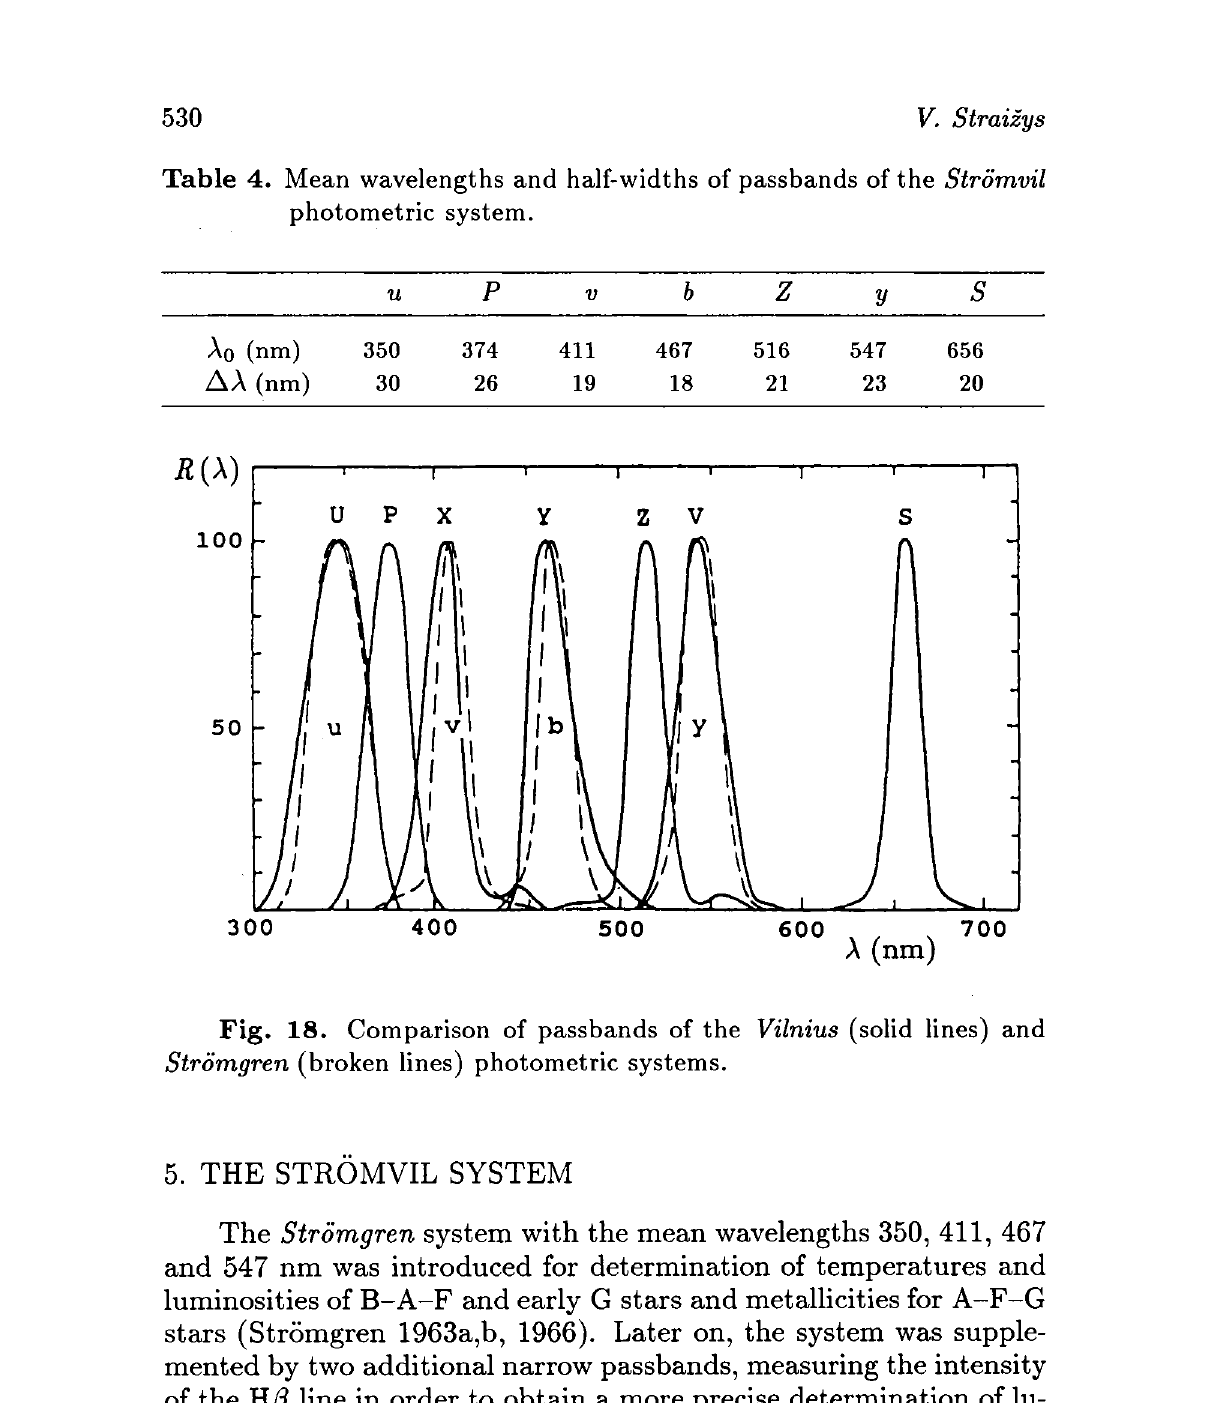
Table 4. Mean wavelengths and half-widths of passbands of the Stromvil photometric system.